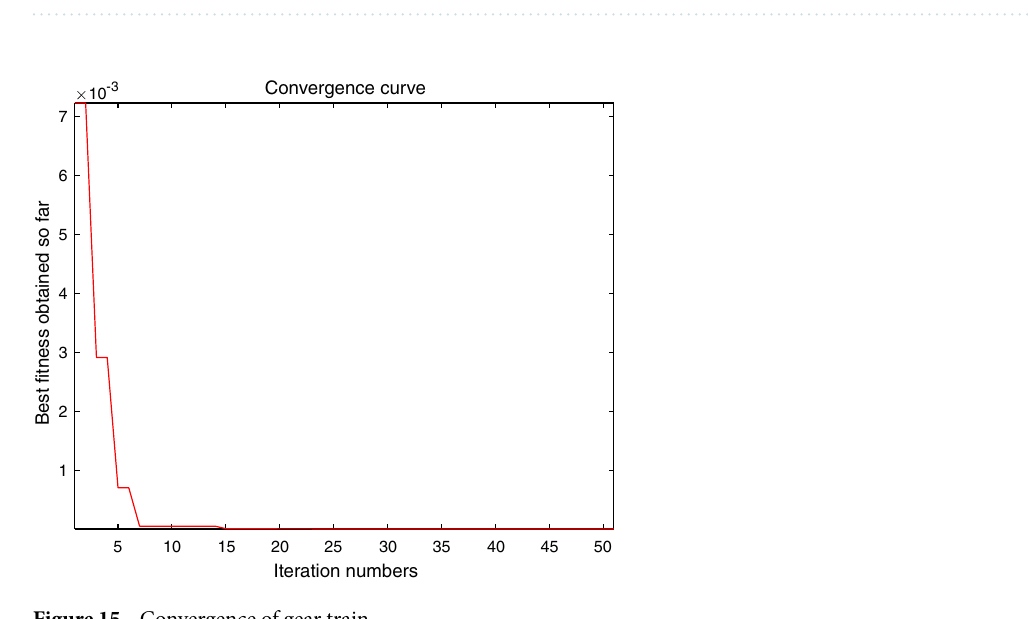
Figure 15. Convergence of gear